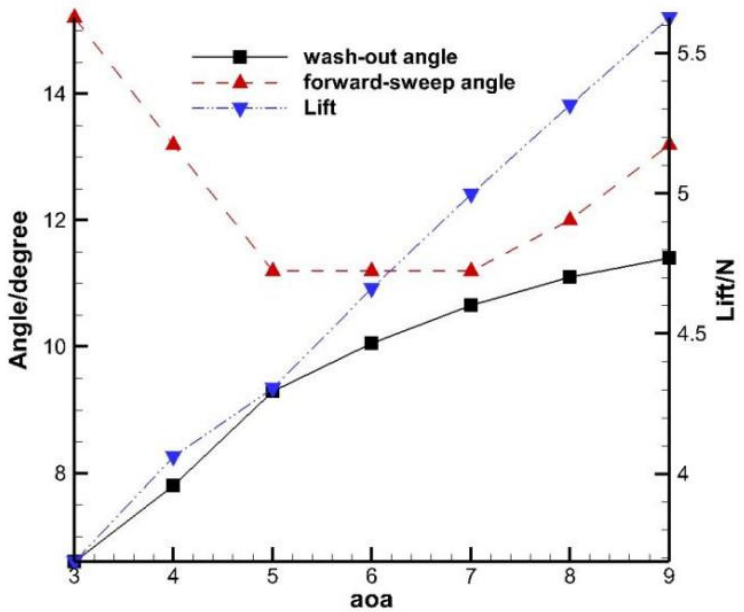
Figure 10. The variation of wash-out angle and forward-sweep angle that meet the requirement of drag equals thrust and pitching moment is zero.